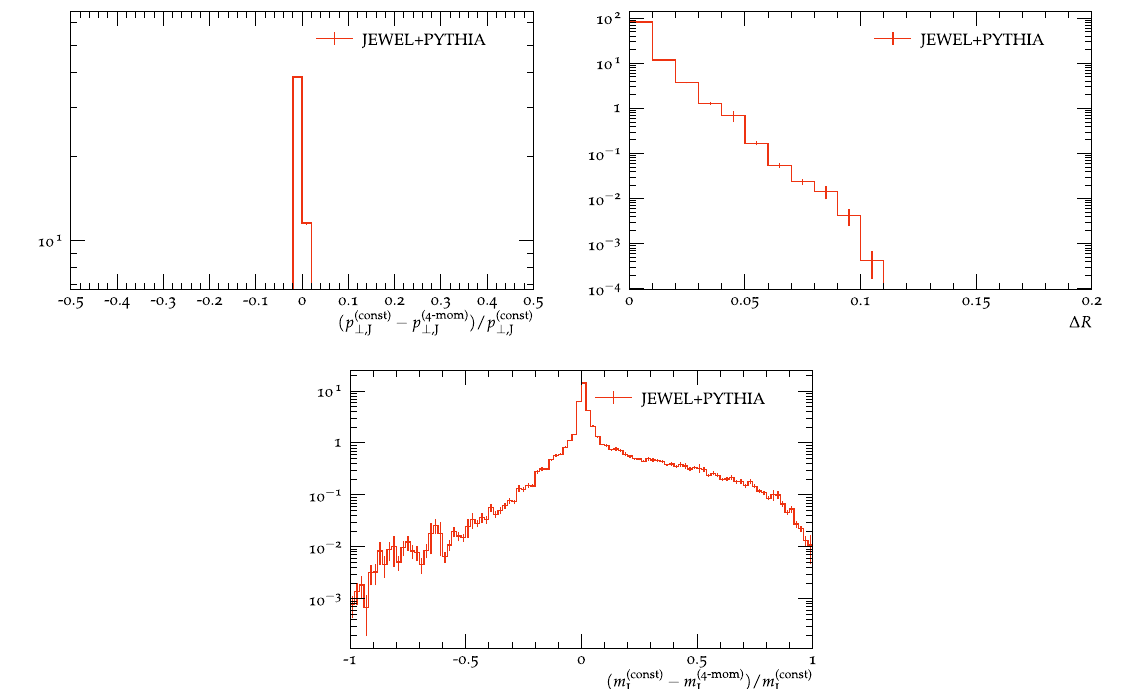
(cid:3) ((cid:2)φ) 2 + ((cid:2)η) 2